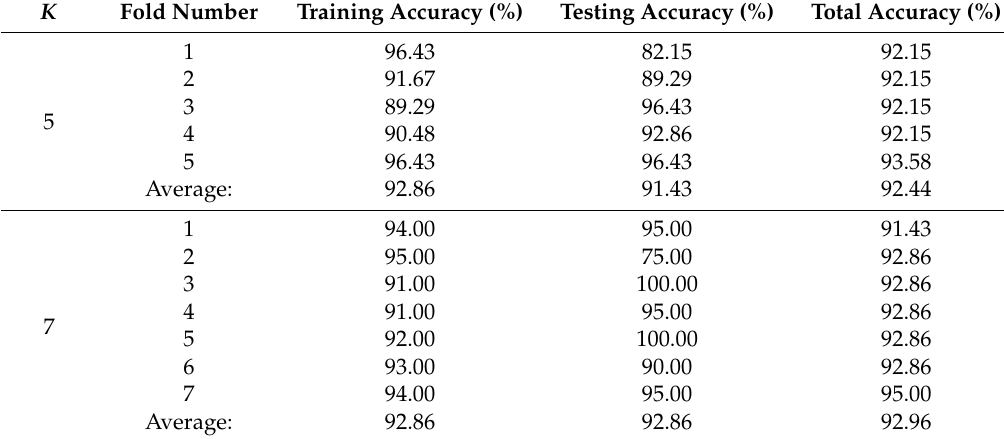
Table 5. Artificial Neural Network (ANN) classifier accuracy with K -fold